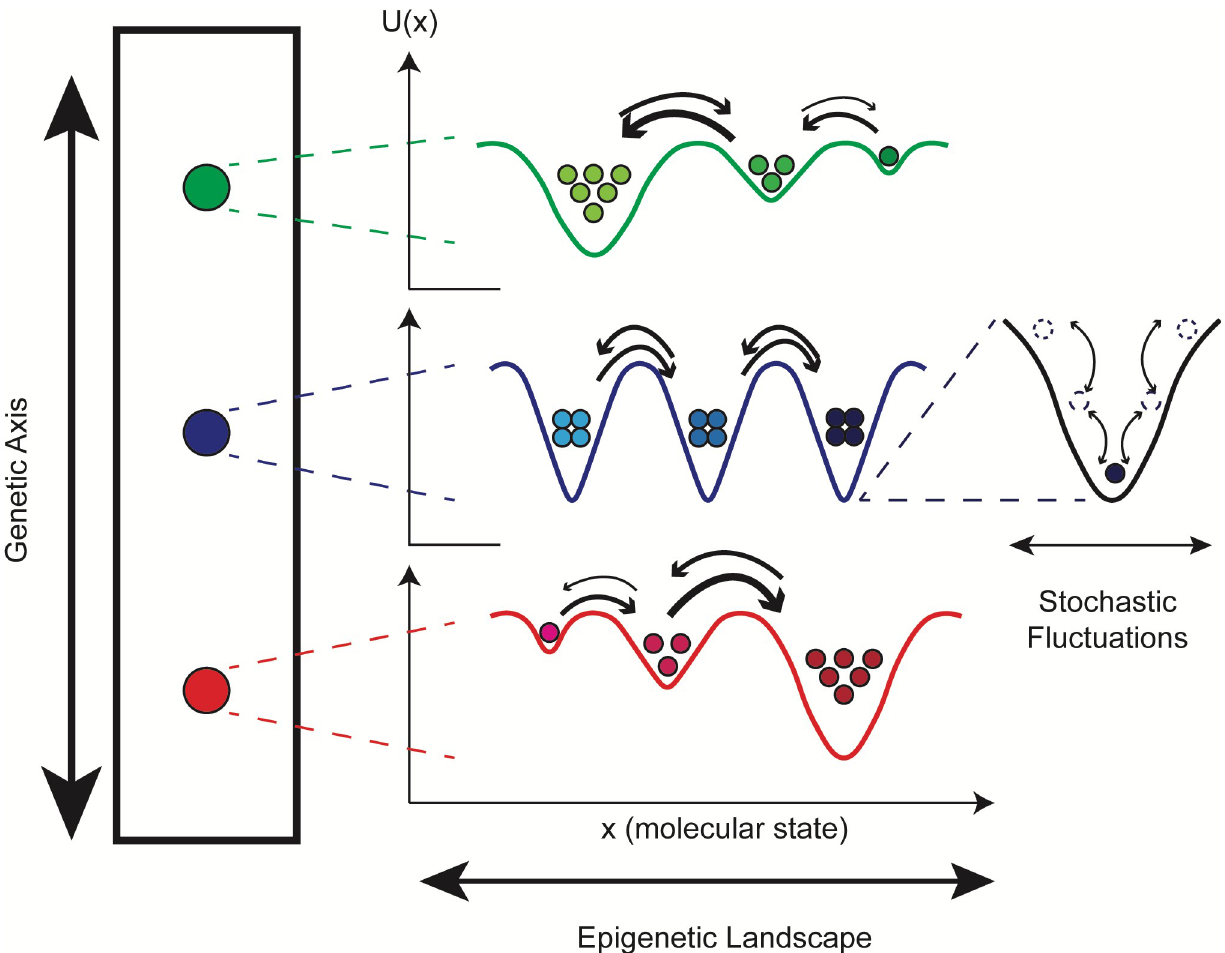
Fig 1. Multiple levels of heterogeneity are believed to operate within tumors. (left) The genetic “axis” defines accumulating mutational differences that have an effect on phenotype, e.g., drug sensitivity. Although depicted linearly for simplicity, note that mutational accumulation is often nonlinear, occurring instead in a branching manner. (middle) Each genetic clone has an associated epigenetic landscape, where cells are distributed across basins, known as “attractors.” The topography of the epigenetic landscape is defined by the dynamical biochemical network that controls cell fate and function. Quasi-potential energy, U(x) , lies along the y-axis and quantifies the relative stabilities of basins; molecular state lies along the x-axis and refers to position within the high-dimensional molecular state space on which the quasi-potential energy is defined (see S1 Text for further discussion). Note that positions of basins across genetic states will not necessarily align (since mutations alter the epigenetic landscape) and they are purposely not aligned in the illustration. (right) Cell states fluctuate within epigenetic basins due to intrinsic (e.g., gene expression) and extrinsic sources of noise. Most fluctuations are minor and do not significantly change the cell state but occasionally a large fluctuation results in a barrier crossing, i.e., a phenotypic state